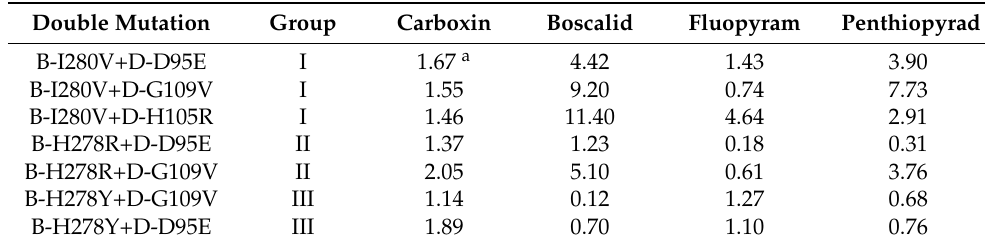
Table 2. The synergistic activity of the combination of different single point mutations in SDHI resistance.